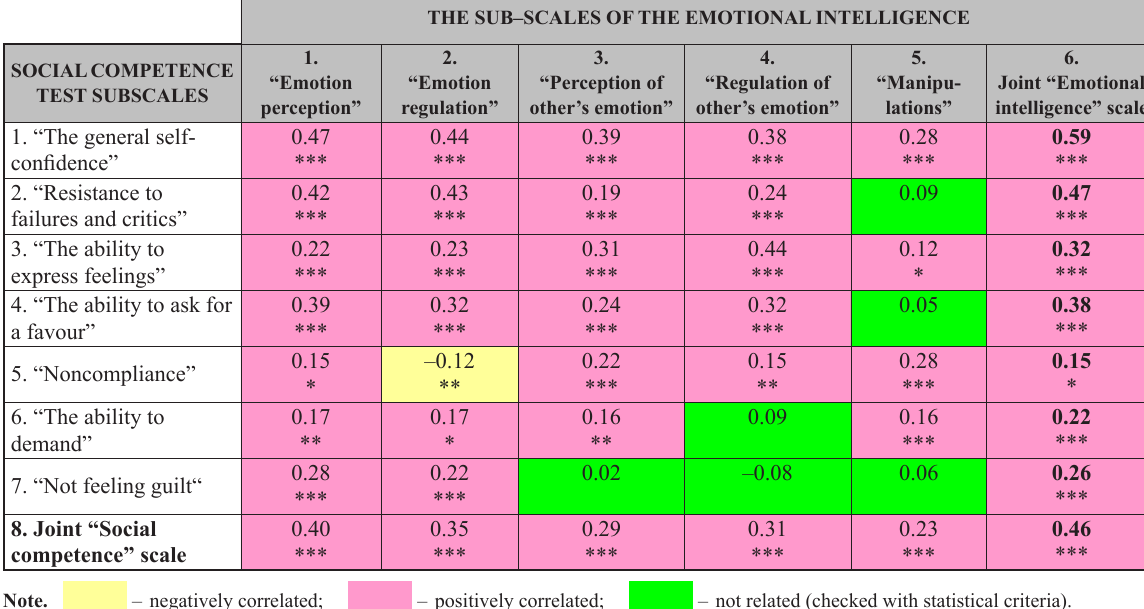
Table 2. Correlations (Spearman’s correlation coefficient) between the EI-DARL-V1 and Social Competence Test